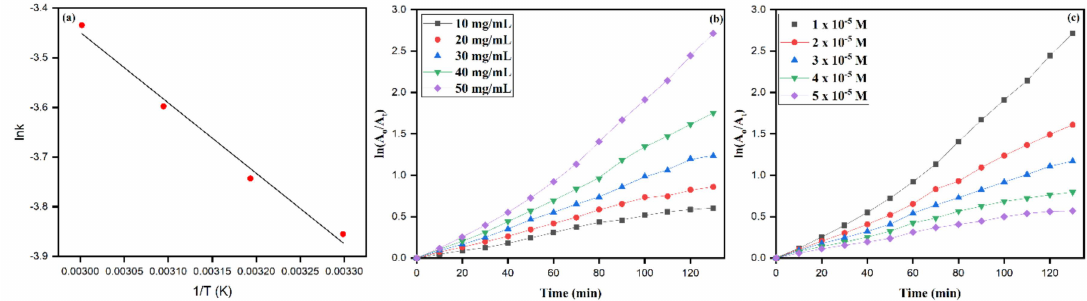
Figure 13. ( a ) Arrhenius plot (lnk vs. 1 / T curve) for calculation of activation energy (Ea). ( b ) First-order photocatalytic degradation kinetics at di ff erent AgNPs catalyst dosages (plots of ln(A o / A t ) vs. irradiation time (min)). ( c ) Plots of ln(A o / A t ) vs. irradiation time (min) as a function of initial RB dye